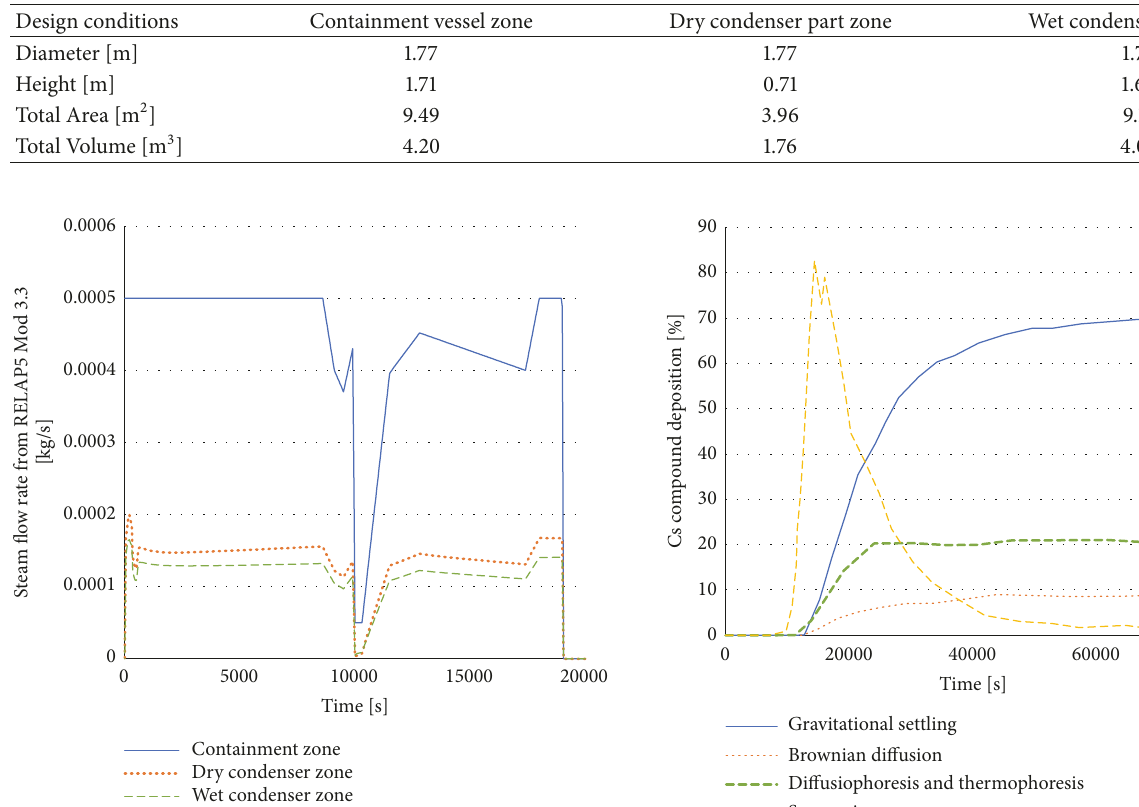
Table 9: Design conditions of containment zone, dry condenser zone, and wet condenser zone in RELAP5 Mod 3.3.